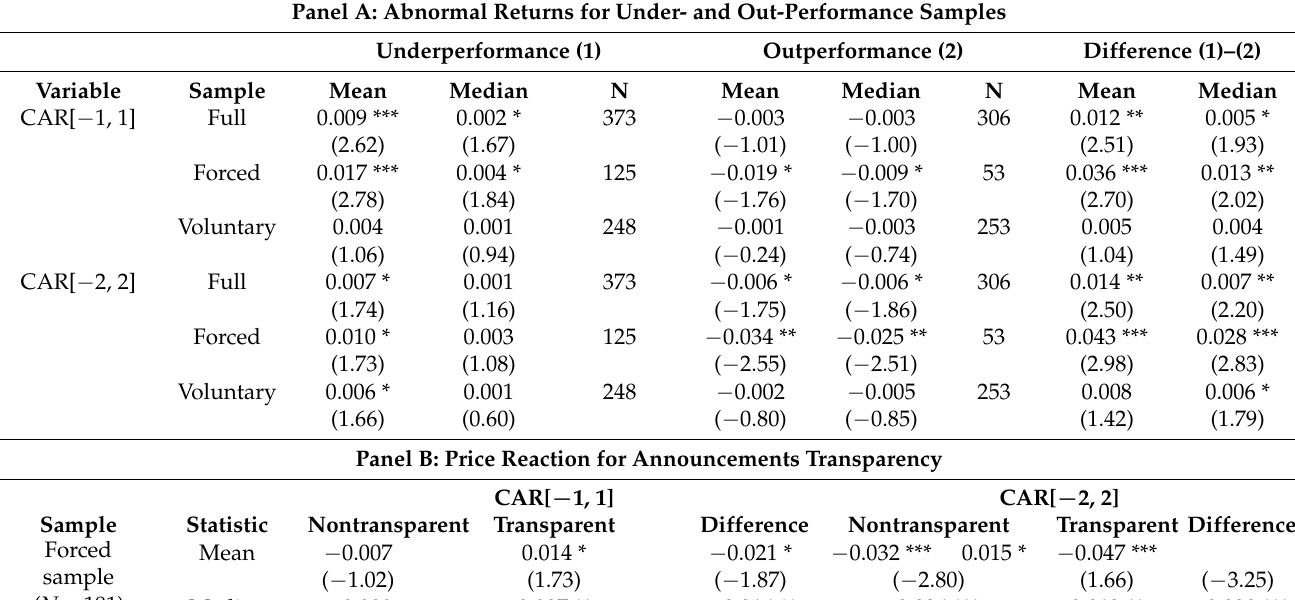
Table 3. Previous performance and stated reasons of dismissal effects on price reactions to CEO turnover announcements. Panel A: Abnormal Returns for Under- and Out-Performance Samples Underperformance (1) Outperformance (2) Difference